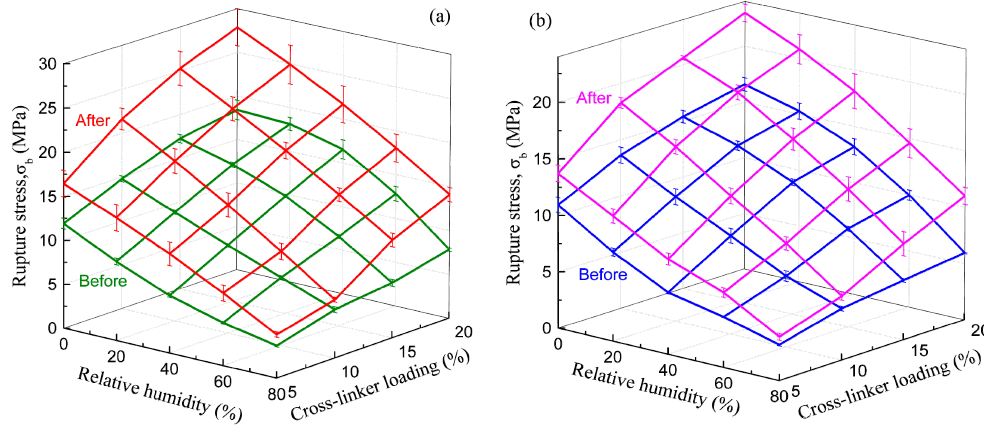
Figure 7. Effect of post-cure treatment on moisture-dependent rupture stress of ( a ) xPVAc/EMDI and ( b ) xPVAc/ p -MDI.